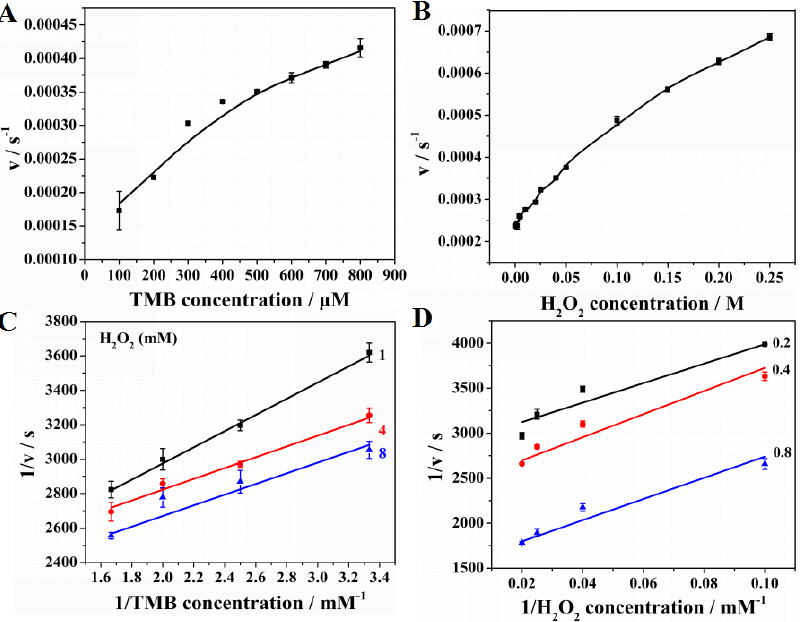
Figure 9. Steady-state kinetic assays of CF300, the reaction velocity ( v ) was measured using 20 µ g/mL of CF300 in 20 mM PBS (pH = 3) at room temperature. The TMB concentration was varied and the concentration of H 2 O 2 was 4 mM ( A ); the H 2 O 2 concentration was varied and the concentration of TMB was 0.4 mM ( B ); and the double-reciprocal plots of peroxidase-like activity of CF300 with a fixed concentration of one substrate relative to varying concentration of the other substrate ( C , D ).